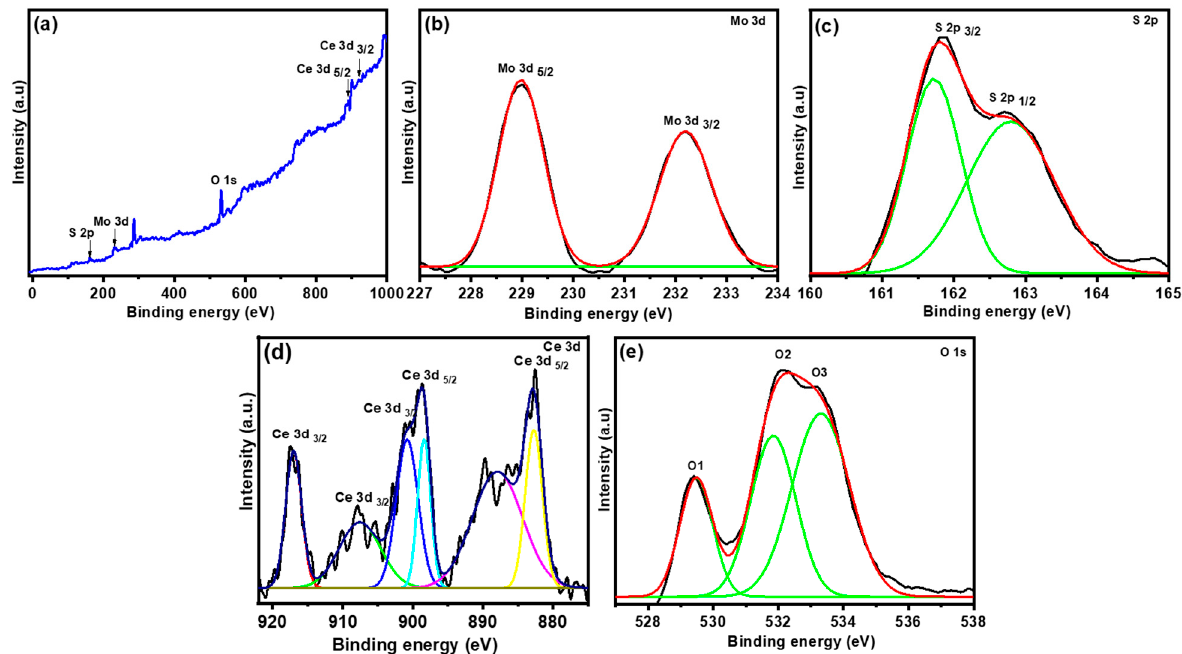
Figure 3. ( a ) X-ray photoelectron spectroscopy (XPS) spectrum of CeO 2 /MoS 2 composite, ( b ) Mo 3d spectrum, ( c ) S2 p spectrum, ( d ) Ce 3d spectrum, and ( e ) O 1s spectrum.